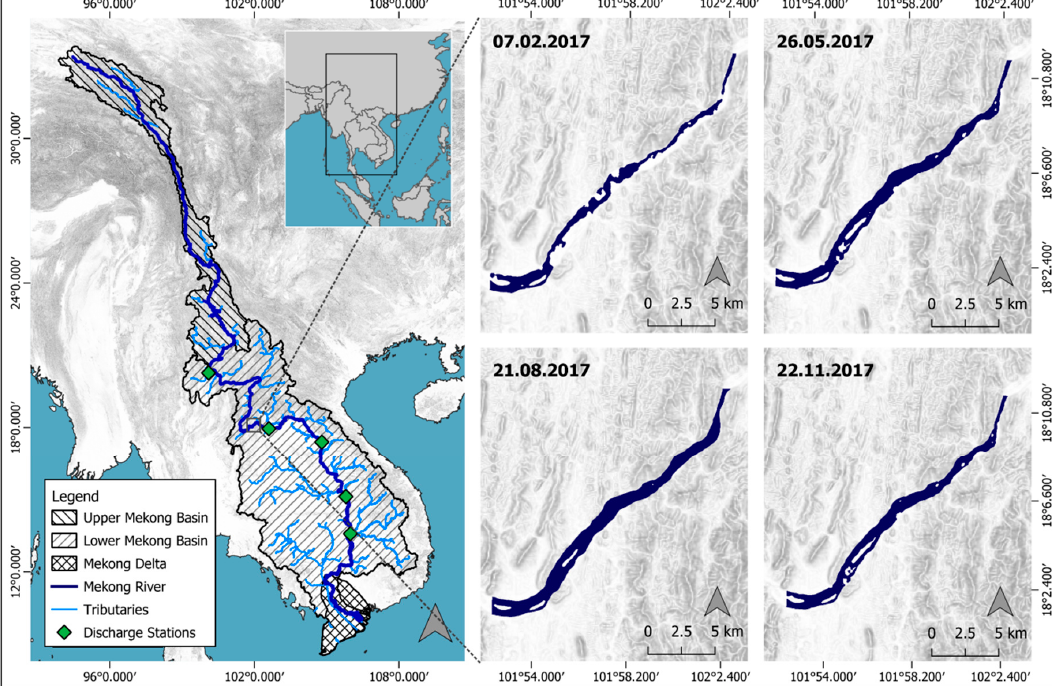
Figure 1. Location and overview of the Mekong River Basin (left) and the study area (right), with example river masks for each quarter. The tributary rivers are shown up to Strahler stream order 5.